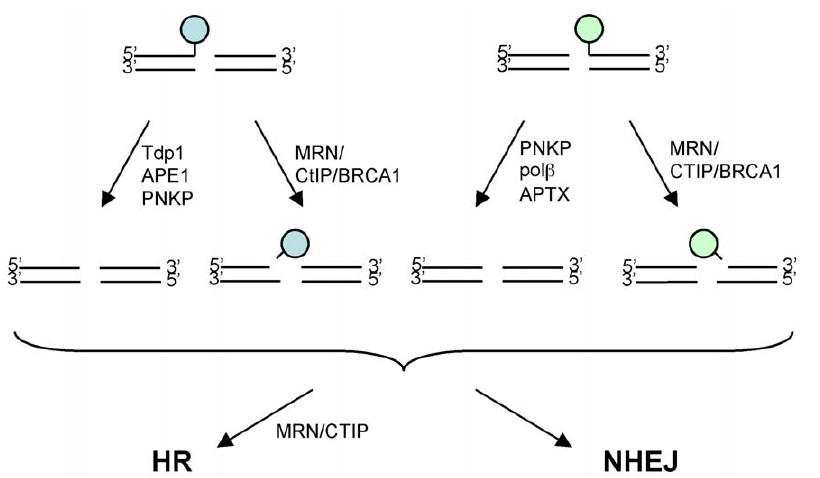
Figure 7. Model for processing the modified DNA ends. Topoisomerase inhibitors induce chemical modification (indicated by a circle) at 3 9 and 5 9 ends of DSBs, and thereby inhibit subsequent DSB repair. There are two distinct pathways to eliminate such chemical modifications from DSBs. In the first pathway, tyrosyl-DNA phosphodiesterase1 (Tdp1), polynucleotide kinase 3 9 -phosphatase (PNKP), and AP endonuclease I (APE1) remove various chemical modifications from the 3 9 ends of DSBs, while PNKP, DNA polymerase b (Pol b ), and aprataxin (APTX) remove those from the 5 9 ends of DSBs (the arrows on the left). In the second pathway, MRN-CtIP-BRCA1 may act as an endonuclease and eliminate oligonucleotides covalently bound to polypeptide (the arrows on the right). The resulting processed DSBs are subject to homologous recombination (HR) and nonhomologous- end-joining (NHEJ)-dependent DSB repair.